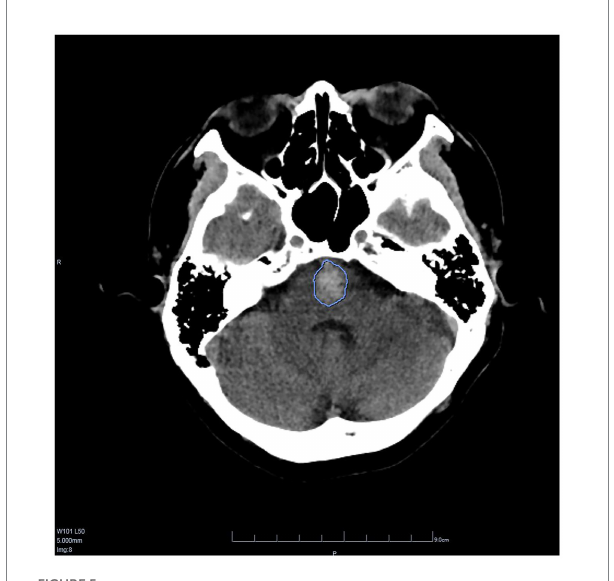
FIGURE 5 A screenshot of DEEPWISE Medical Artificial intelligence auxiliary